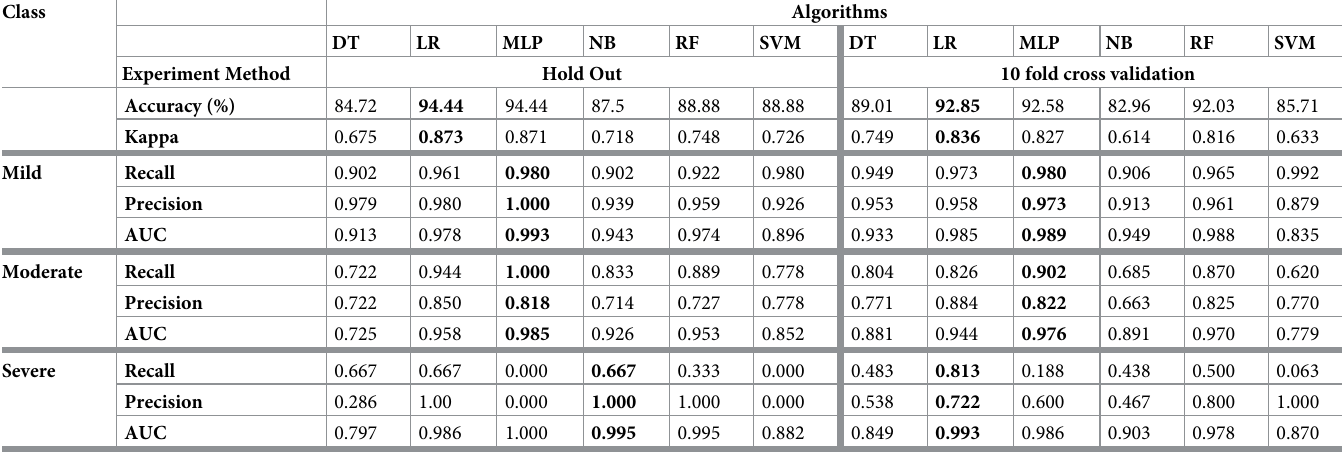
Table 5. Summary of the results obtained using the dataset1 (Anemia original dataset). Class